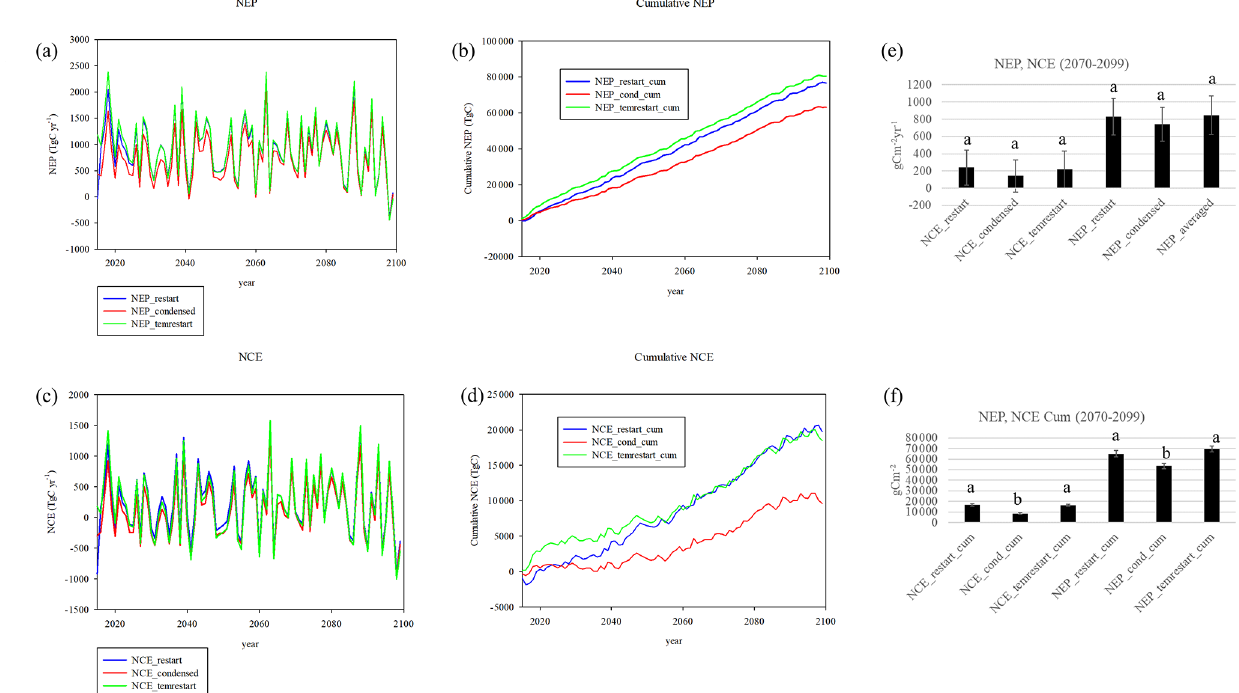
Figure 3. Comparison of NEP and NEC between the RESTART, CONDENSED, and TEMRESTART runs; (a) NEP, (b) cumulative NEP, (c) NCE, and (d) cumulative NCE; (e) NEP, NCE comparison 2070–2099 means (error bars 1 standard deviation), (f) cumulative NEP, NCE comparison, 2070–2099 means (error bars 95% confidence interval). ANOVA analysis for (d) and (e) based on P < 0 .